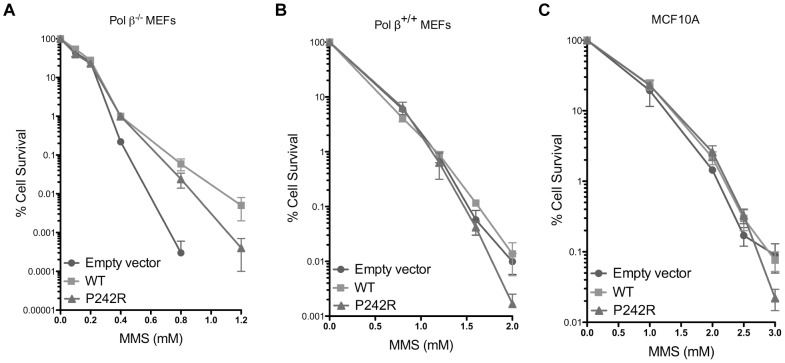
P242R Pol β confers slight sensitivity to MMS compared to WT.Clonogenic survival assays were conducted with (A.) Pol β−/− MEFs, (B.) Pol β+/+ MEFs, or (C.) MCF10A pools expressing WT or P242R Pol β. Filled circles represent results from pools expressing empty vector, filled squares represent pools expressing WT Pol β, and filled triangles represent pools expressing P242R Pol β. Data are plotted as the mean ± SEM (n = 3).